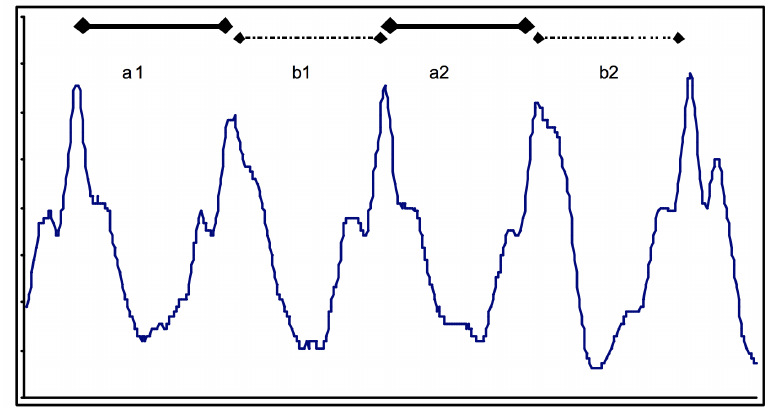
Figure 5. A typical gait pattern detected by an accelerometer, with steps “a” and “b” marked